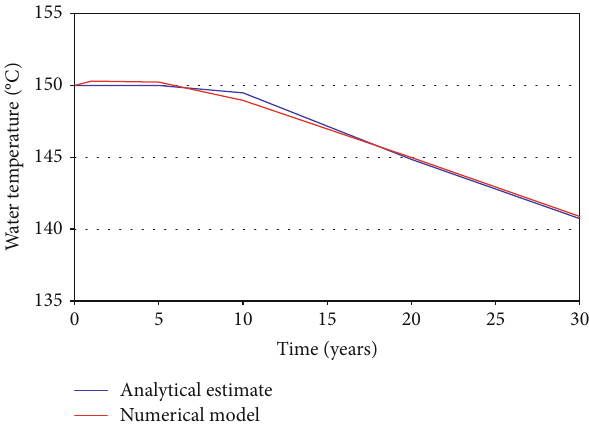
Figure 5: Variation with time of the water temperature at the production